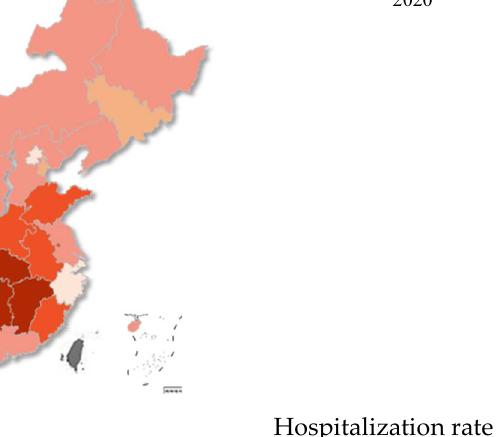
Figure 2. The average number of visits and the hospitalization rate in primary health institutions in China between 2013 and 2020.